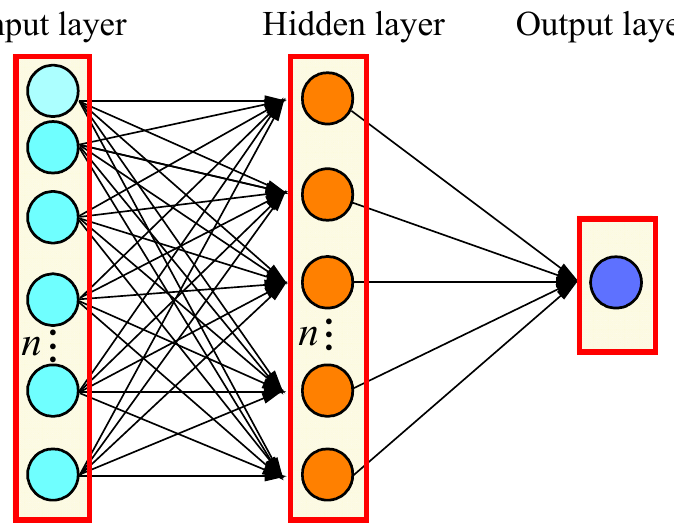
Figure 14. Proposed fully-connected ANN architecture with hidden layers.